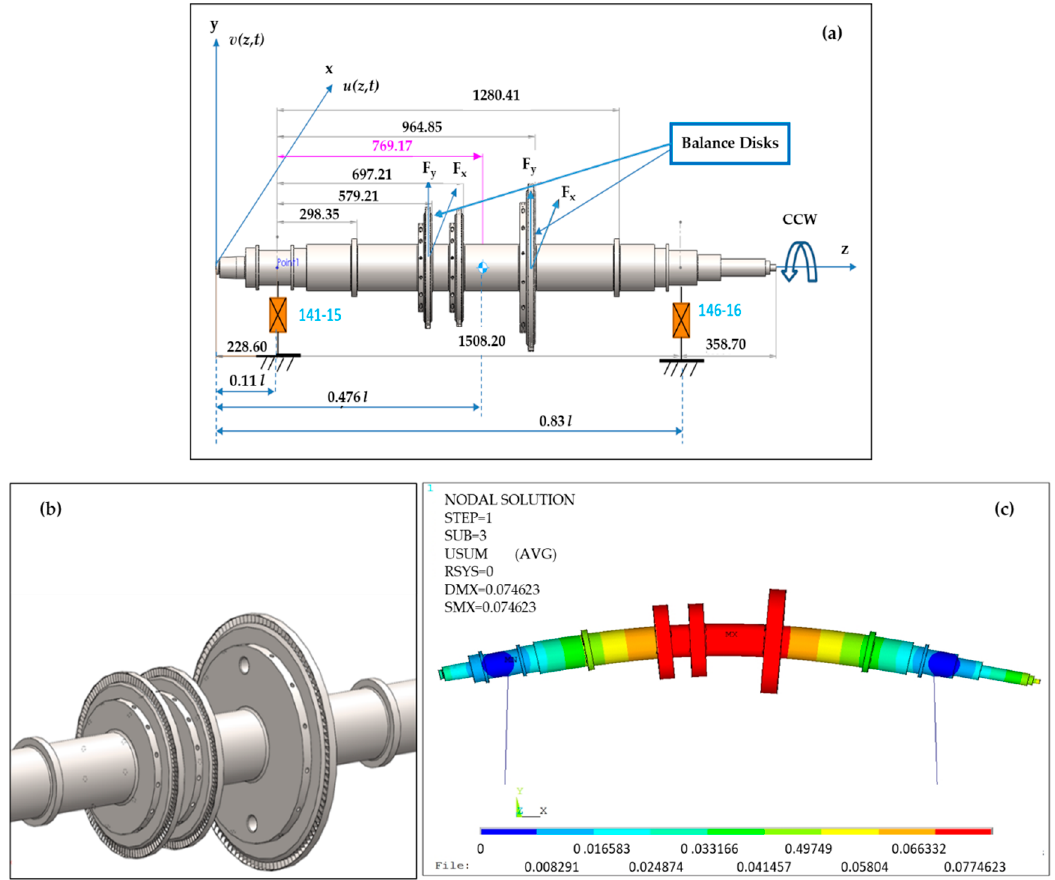
Figure 1. ( a ) System model with dimensions ( b ) modeling in Solidworks ( c ) FEM model of the first mode.